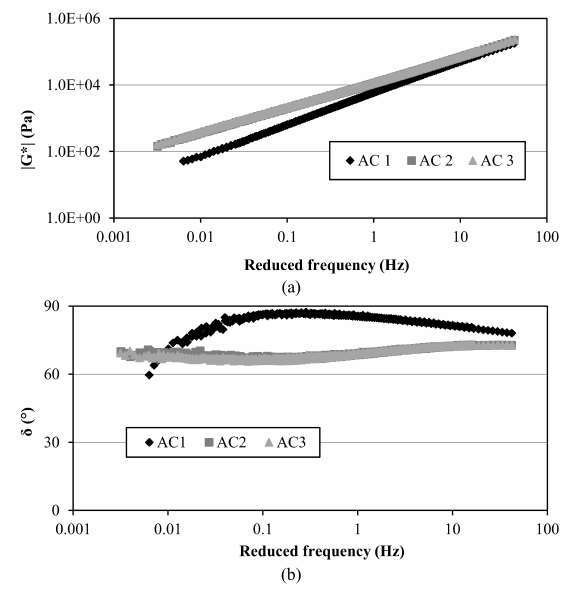
Figure 2: Master curves of: (a) dynamic shear modulus, | G* | and (b) phase angle,